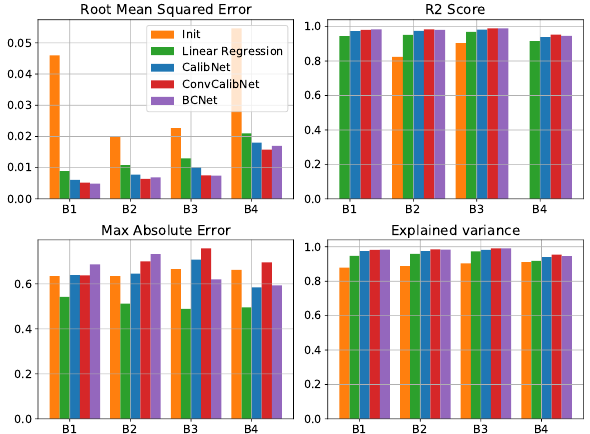
Figure 11. Comparisons of four standard metrics for the initial refletances and the four proposed methods measured on Aude2 dataset.